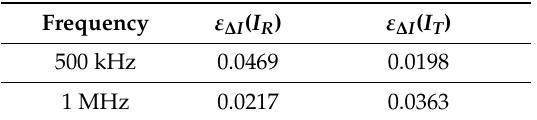
Table 3. Comparison of the difference ε Δ I between results obtained for the finite model (FM) and EqM calculations.